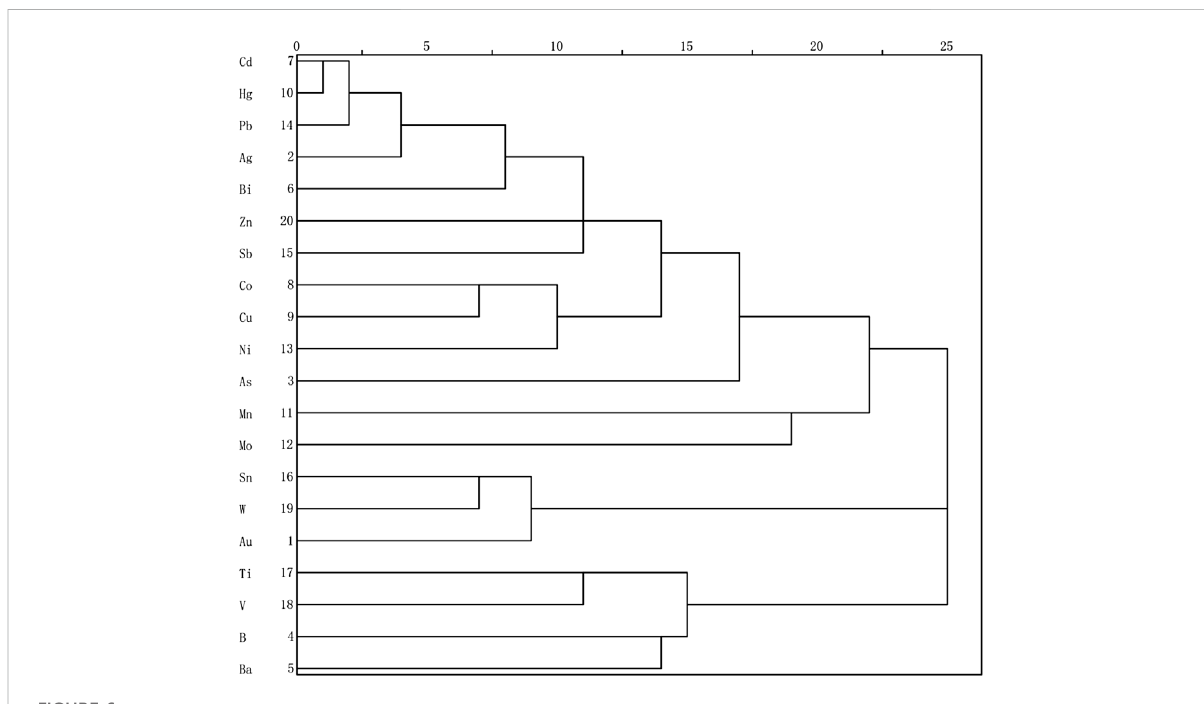
FIGURE 6 R-type cluster analysis pedigree of 20 elements in the samples from the Hongqigou tectonic